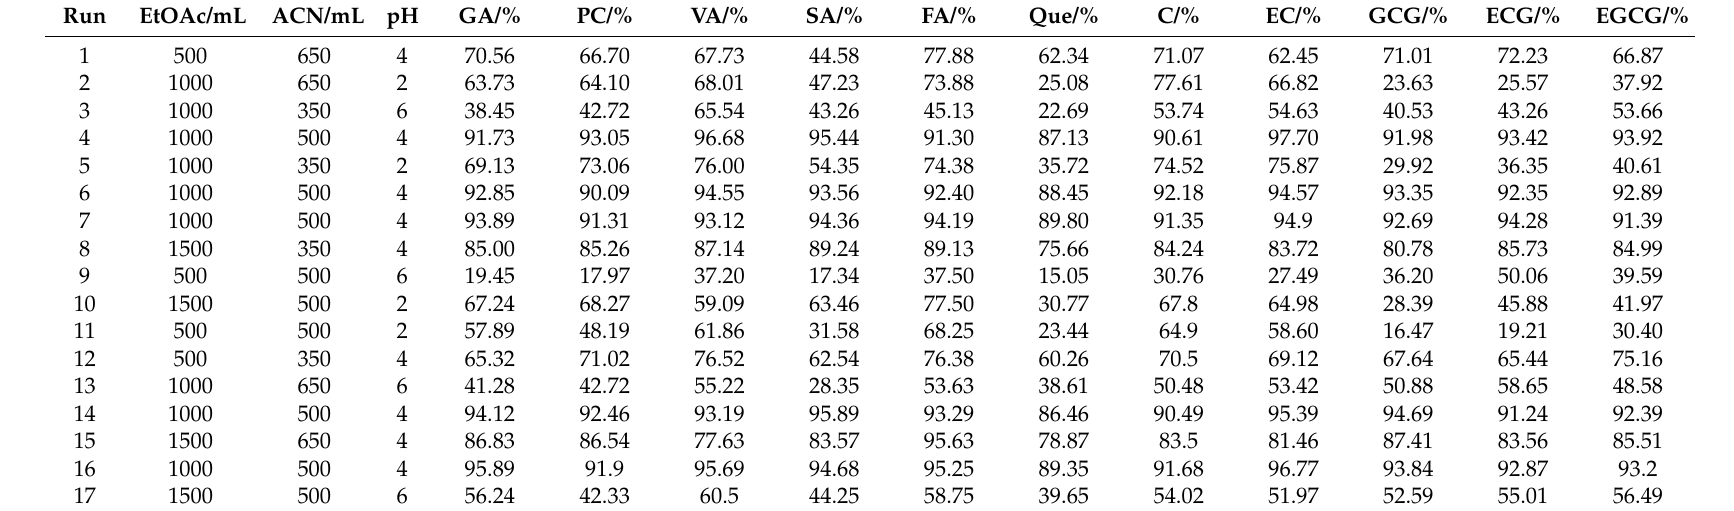
Table 1. Box-Behnken design matrix and observed responses values of the extraction recovery.